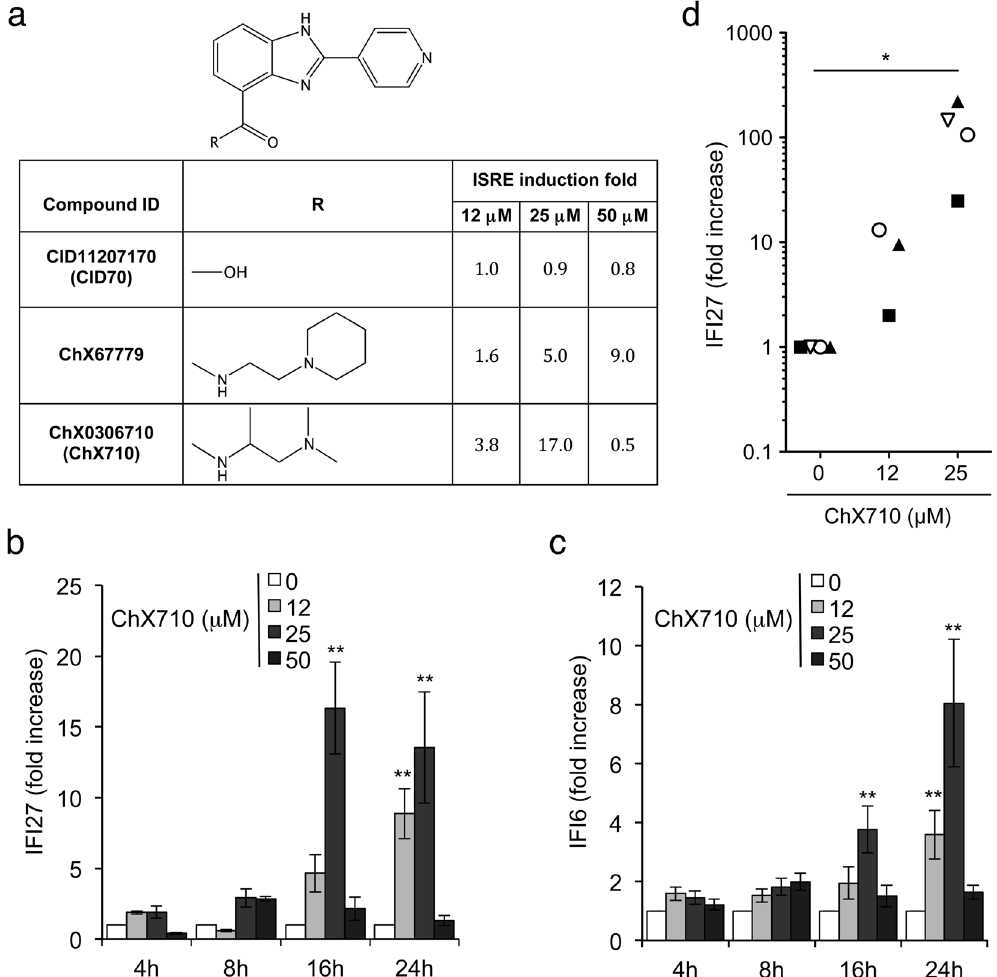
Figure 3. Structure activity relationships and selection of ChX710. ( a ) Chemical structures of ChX67779 and two analogs called CID11207170 and ChX0306710. Compounds were tested for their capacity to induce the ISRE-luciferase reporter gene at three different concentrations. ( b and c ) HEK-293T cells were left untreated (DMSO alone) or incubated with ChX710 at indicated concentrations for 0, 4, 16 or 24 hours. IFI27 ( b ) and IFI6 ( c ) induction levels were determined by RT-qPCR as described above. Experiments were performed in duplicate, and data represent means ± SD. * P < 0.05 and ** P < 0.01 as calculated by two-way ANOVA with Bonferroni’s post hoc test. ( d ) Human PBMCs were treated for 24 hours with DMSO alone or ChX710 at 12.5 or 25 μ M, and IFI27 inductions was determined by RT-qPCR as described above. Data correspond to four healthy donors depicted by different symbols. * P < 0.05 as calculated by one-way ANOVA with Bonferroni’s post hoc